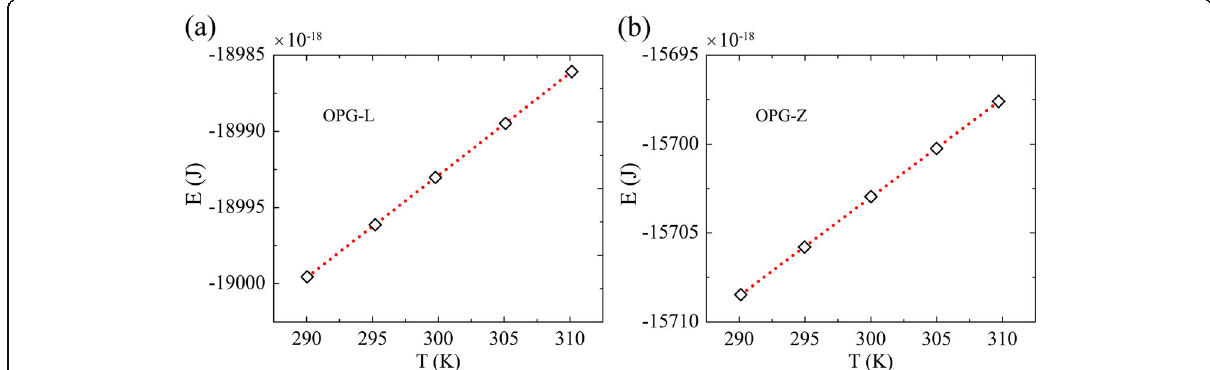
Fig. 6 The variation of energy as a function of temperature for a OPG-L and b OPG-Z. The slope of the energy-temperature curve denotes the heat capacity. The corresponding heat capacities are 4.163 E-23 J/K, and 4.126 E-23 J/K, respectively, per